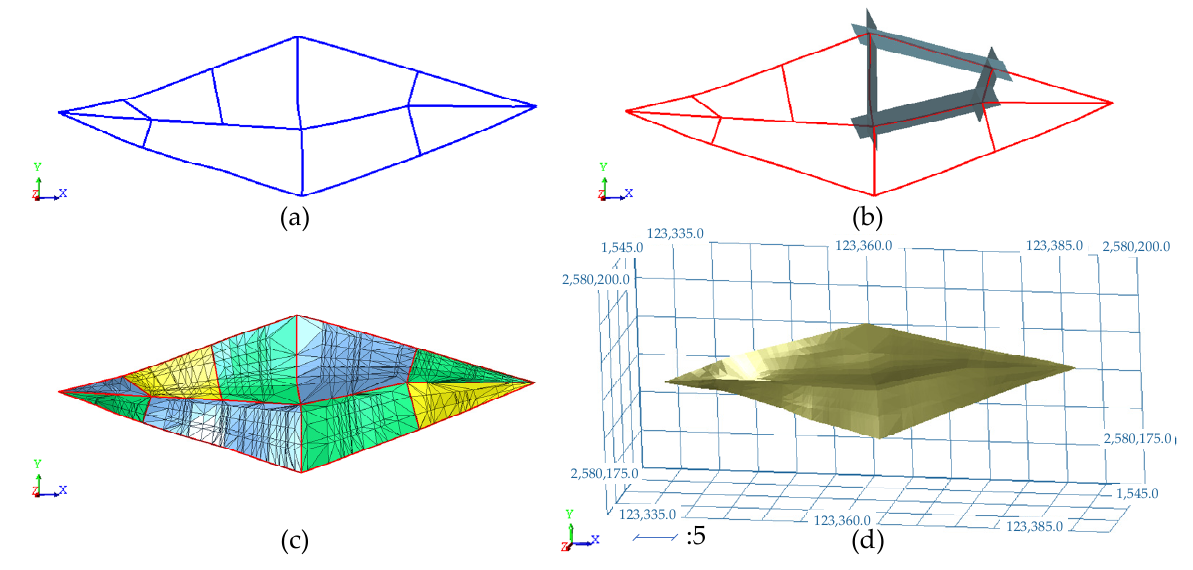
Figure 12. Experimental results of the first set of contour polylines: ( a ) the original contour polylines; ( b ) closed-loop division; ( c ) single closed-loop modeling; ( d ) sub-mesh combination.